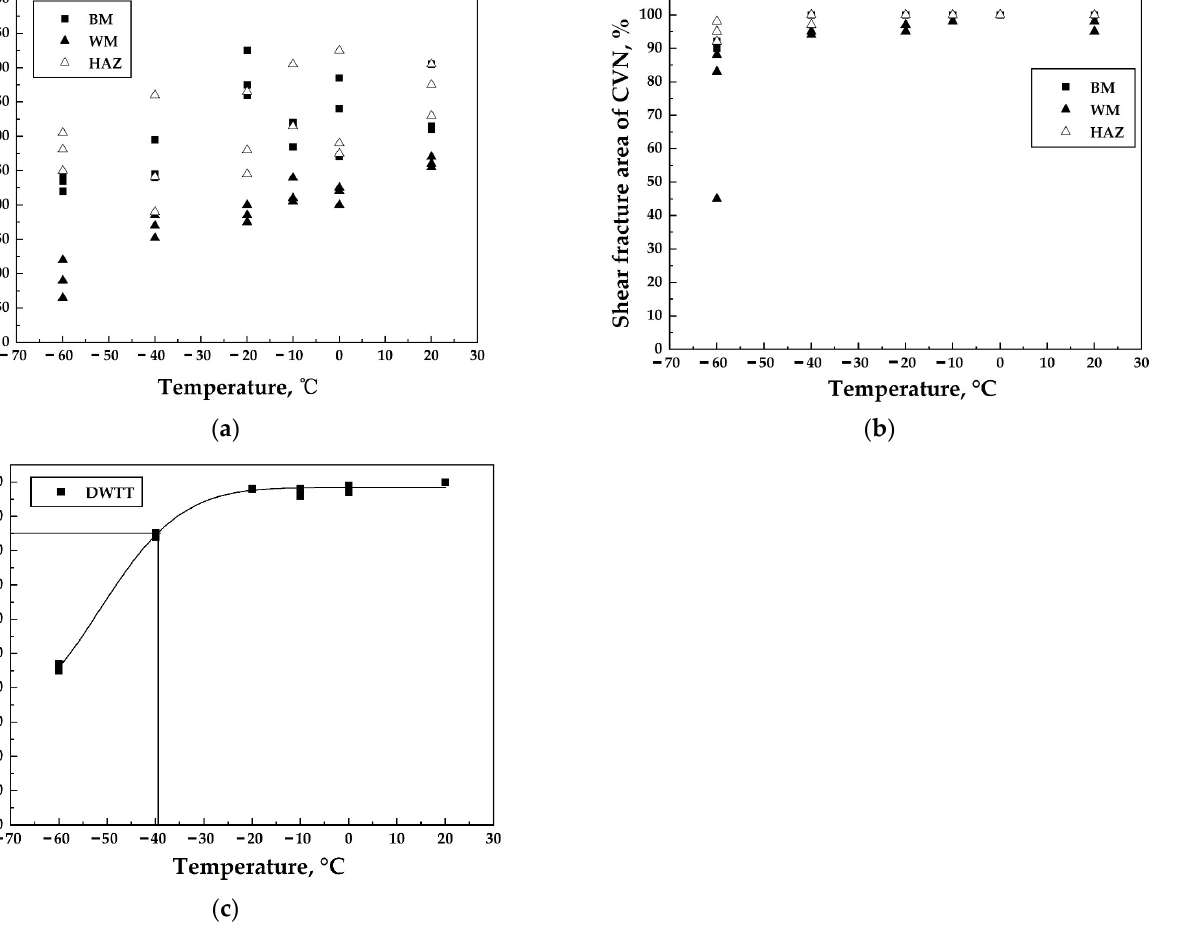
Figure 4. Series CVN and DWTT curves of BM, WM and HAZ. ( a ) CVN absorbed energy and ( b ) shear fracture area of CVN and ( c ) shear fracture area of DWTT.